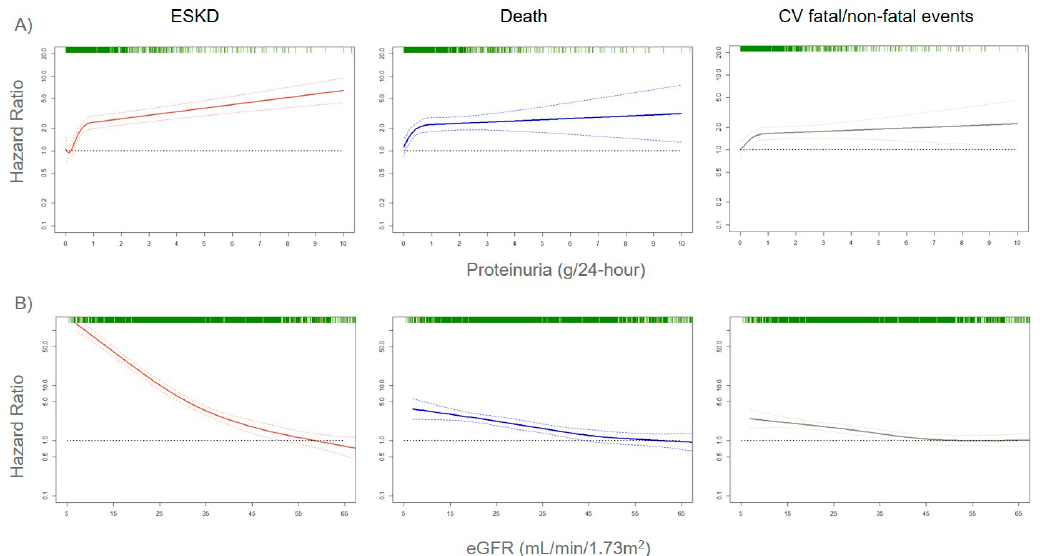
Figure 1. Adjusted risks for end-stage kidney disease (ESKD), death, and cardiovascular (CV) fatal and non-fatal events, by 24-h proteinuria (panel A ) or estimated glomerular filtration rate (eGFR) (panel B ) levels. Solid lines represent hazard ratios, whereas dashed lines the 95% confidence intervals. Hazard ratios were modeled by means of restricted cubic spline (RCS) due to the non-linear association with the endpoints. Knots are located at the zeroth, 25th, 50th, and 75th percentiles for proteinuria and 15, 30, 45, 60 mL / min / 1.73 m 2 for eGFR. Risks are adjusted for the four-variable Tangri equation [26]: age, gender, eGFR, and proteinuria. Rug plots on the x -axis at the top (colored green) represent the distribution of observations. Data source: pooled analysis of six cohorts of CKD patients referred to Italian nephrology clinics [27].